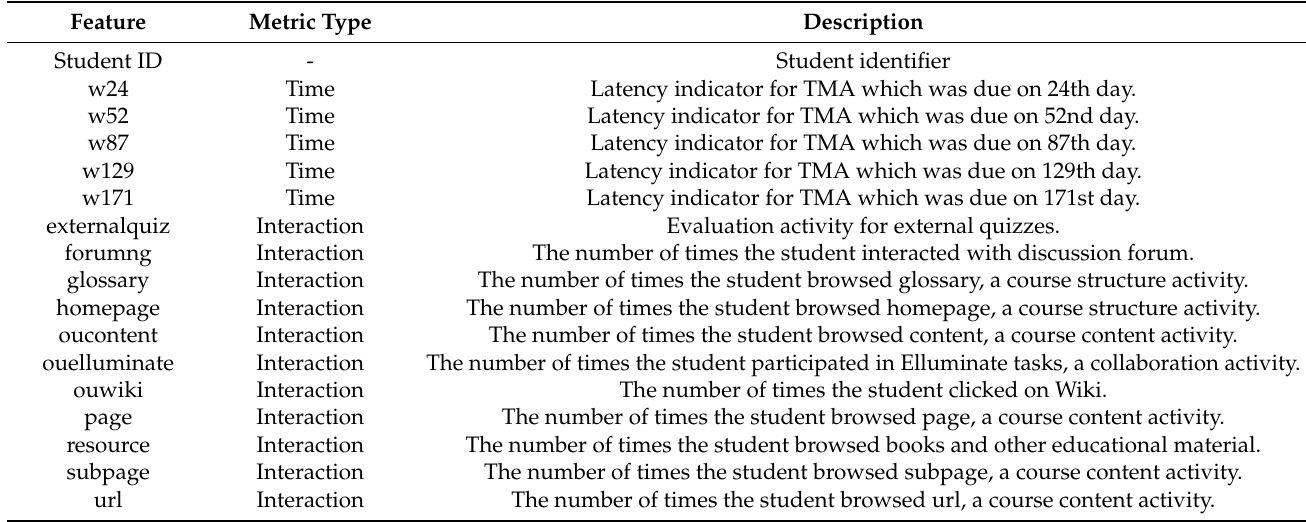
Table 1. New dataset transformed features.